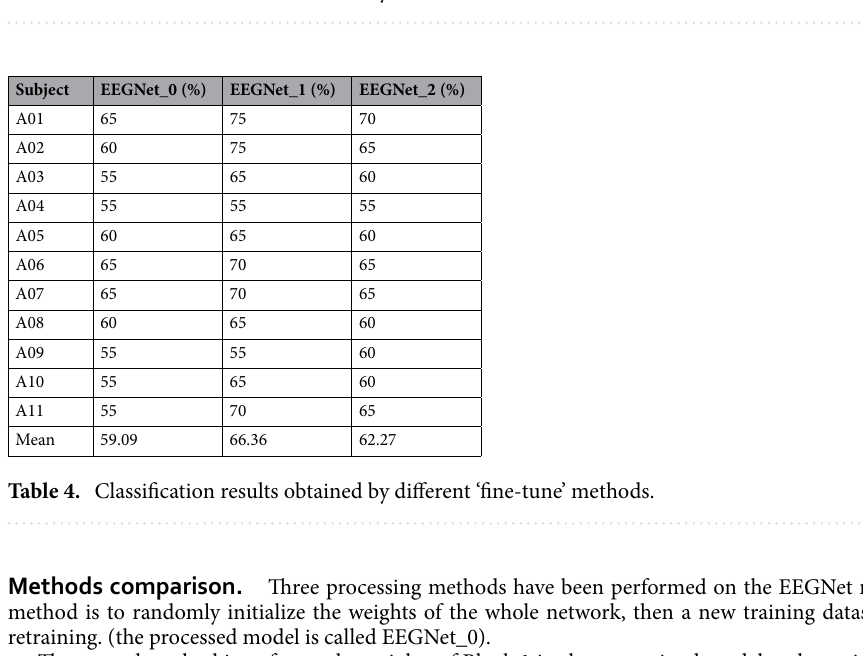
Table 3. Classification results obtained by different ‘fine-tune’ methods.